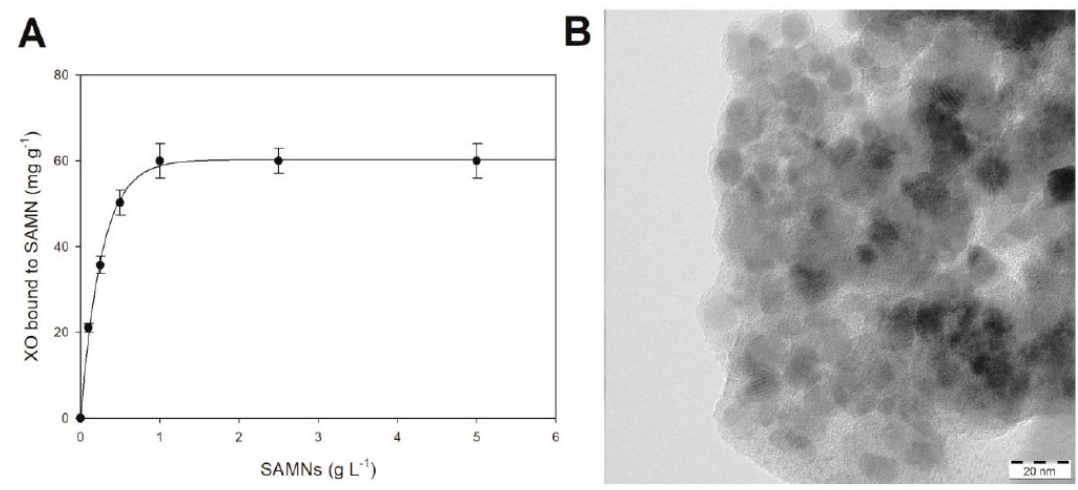
Figure 1. Characterization of the SAMN@XO complex. ( A ) Determination of the amount of xanthine oxidase bound on SAMNs as a function of nanoparticle concentration. ( B ) TEM image of the SAMN@XO hybrid.